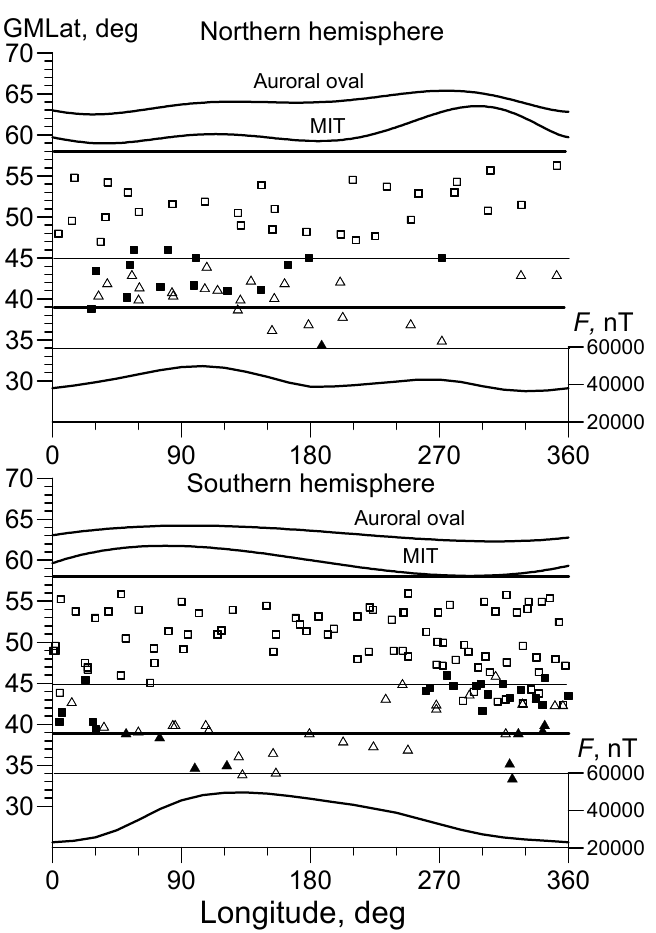
Figure 8. Scheme of localization of the auroral oval, MIT, RIT, and LLT in terms of longitude-latitude in the Northern and Southern hemispheres. The positions of the auroral oval and MIT are given for quiet (Kp = 2) midnight conditions. The RIT (squares) and LLT (triangles) data were obtained during geomagnetic storms in the interval from 00 to 07 LT. Filled and empty symbols correspond to large and low Kp values, respectively. Thick and thin horizontal lines limit the observation areas of RIT and LLT, respectively. F is geomagnetic field intensity.